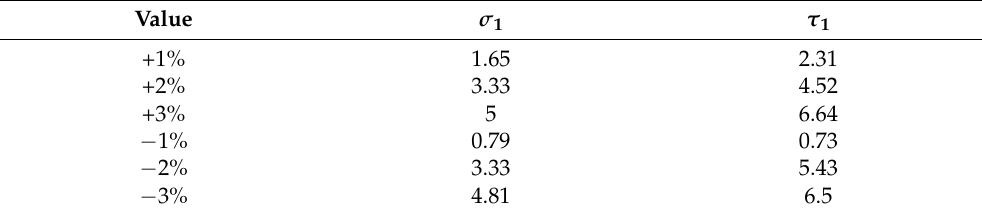
Table 7. Modification (in %) in normal and shear hull girder stresses for different values of the torsion box